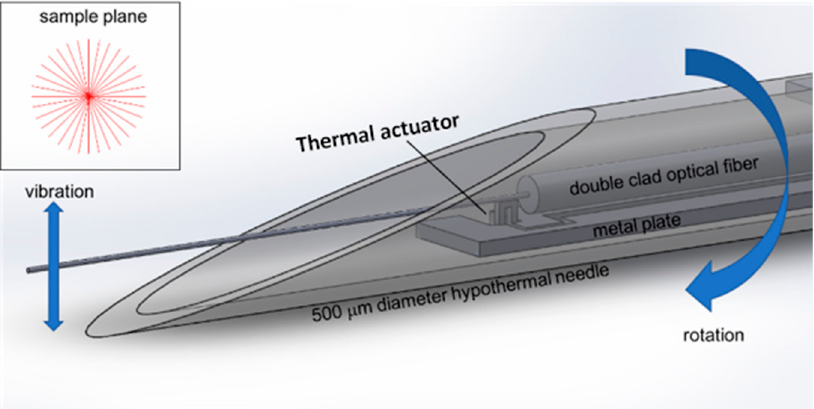
Figure 1. Thermal actuator, dual-clad optical fiber, and micro-cantilever optical fiber mounted in the bore of a hypodermic needle.